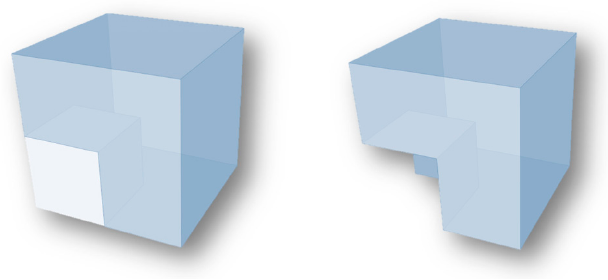
Figure 10. Containment that shares common faces.